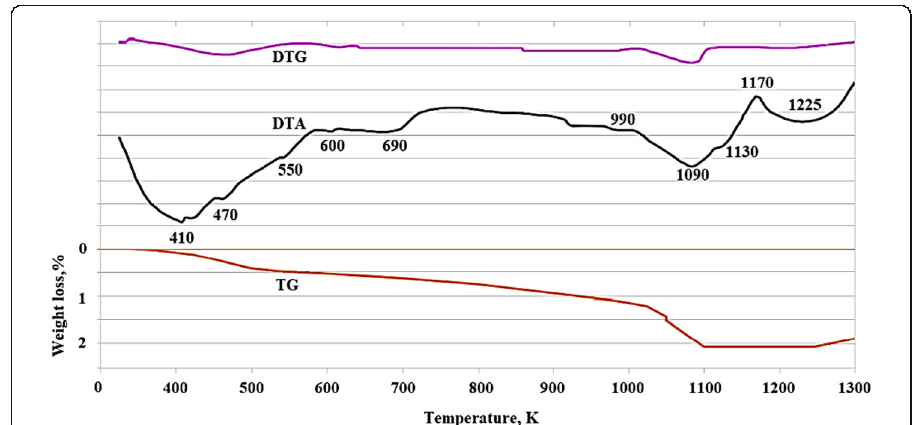
Fig. 5 Derivatogram of GPIS granulated by the hydro-vacuum